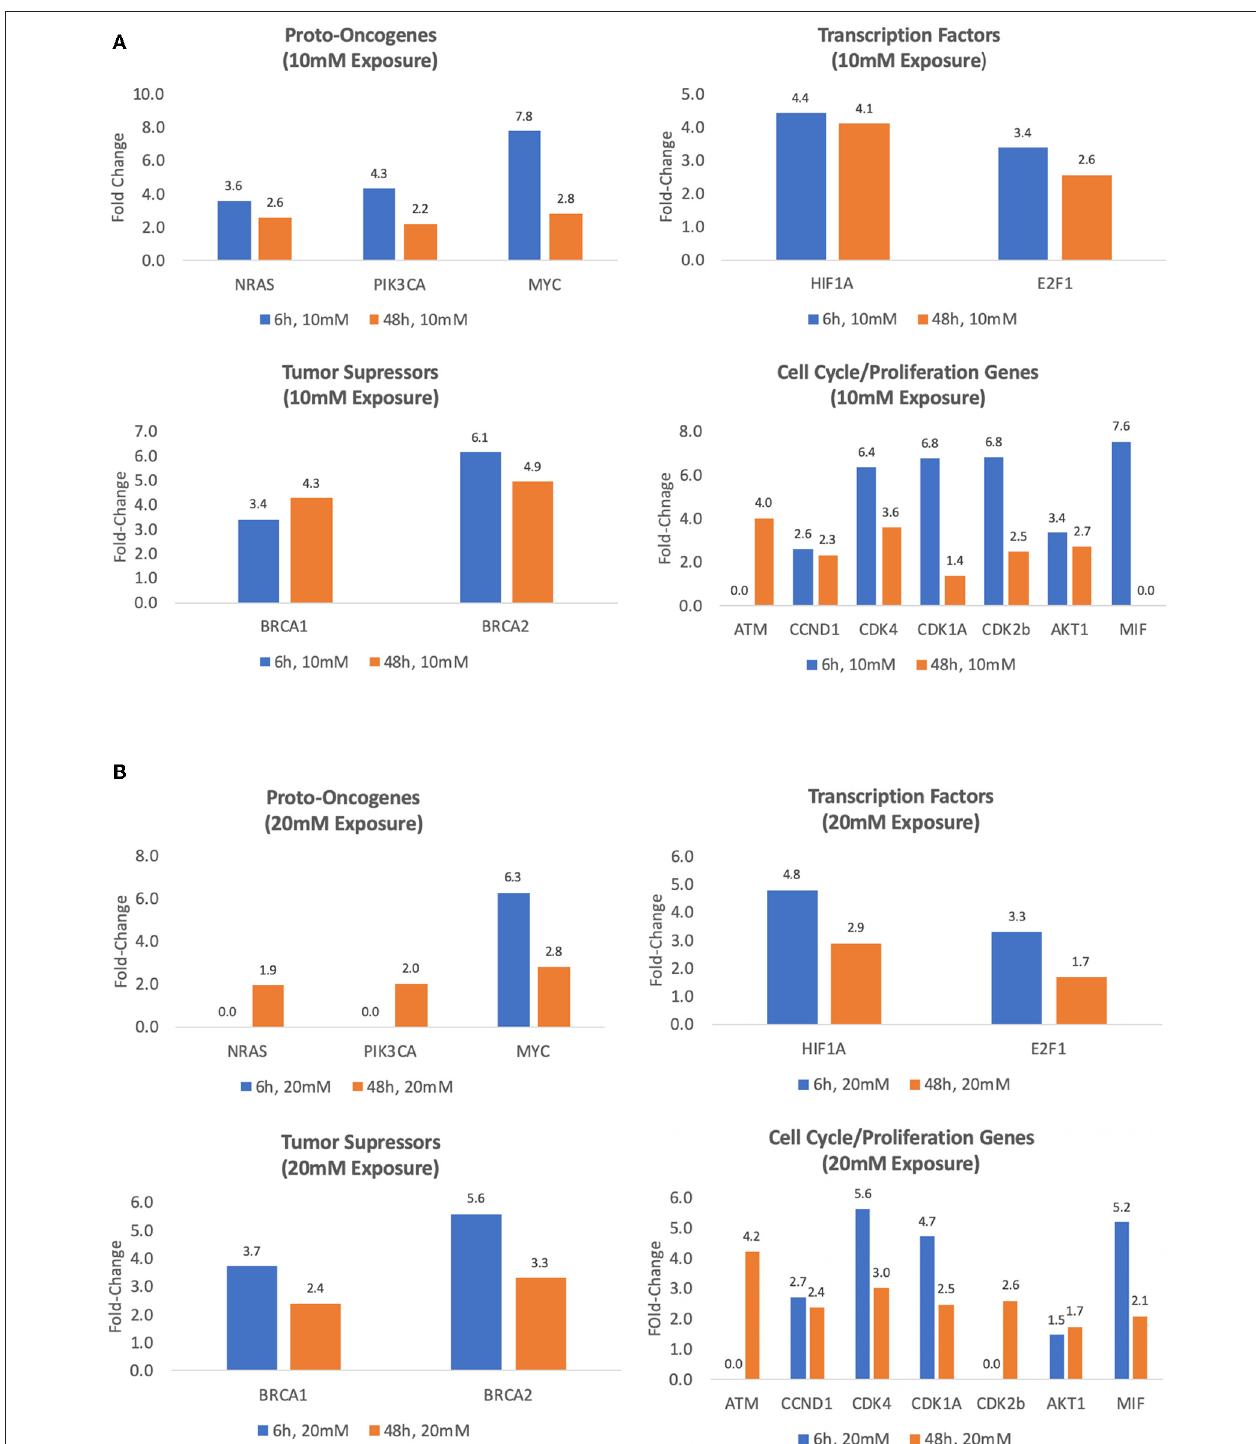
FIGURE 3 | Treatment with exogenous lactate (10 or 20mM) upregulates the expression of several key genes in MCF7 cells. The fold upregulation of expression with 6 and 48h exposure to 10mM (A) or 20mM lactate (B) relative to controls (MCF7 cells cultured for 6h in glucose/glutamine-free media) ( p ’s ≤ 0.05–0.001).